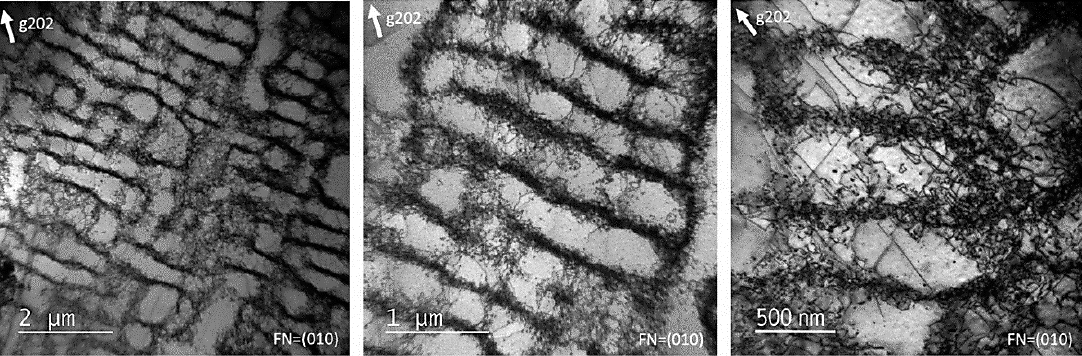
Figure 3. Transition electron microscope (TEM) micrographs of the labyrinth structure from the {010} planes of the cyclically deformed copper.